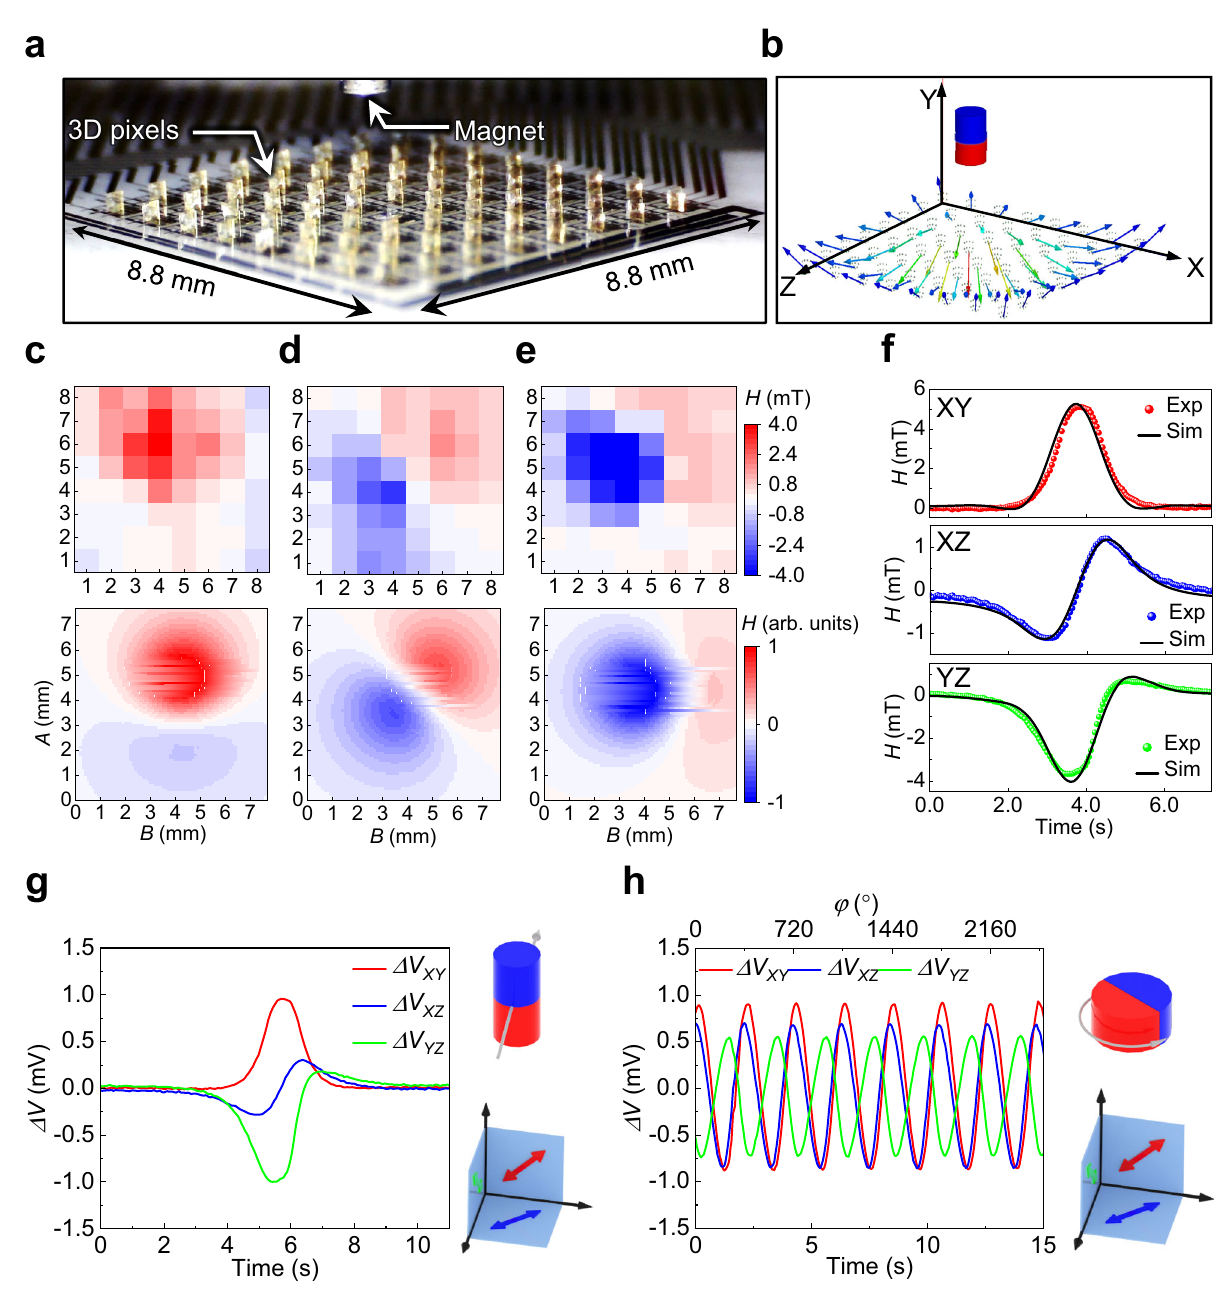
Fig. 3 Static mapping and dynamic tracking of magnetic objects. a Image of an IMOS device together with a small NdFeB permanent magnet. b Simulation result of the magnetic vectors at the locations of the 8 × 8 sensor pixels. c – e Static mapping of the strengths of the magnetic stray fi eld by S XY , S XZ and S YZ sensor arrays on the XY, XZ and YZ planes, respectively. The top panel is from the experimental results and the bottom panel is from simulation. The magnet and its relative position to the sensor array is shown in a . f Simulation result of the dynamic responses of S XY , S XZ and S YZ in a single pixel to the linear motion of a magnet. The dotted lines are measured results and the continuous lines are from simulation. g Dynamic voltage response to a linear motion of the NdFeB permanent magnet monitored by a single pixel. h Dynamic tracking of the rotation of a NdFeB permanent magnet by a single pixel. The output voltages for S XY , S XZ and S YZ change periodically with constant magnitudes emphasizing the stability of the sensors. The 90° phase shift between the signals from S XY and S YZ indicates the orthogonal folding of these two sensing planes. The relative positions of the magnets to the sensor pixels as well as the magnetization directions of the magnets are schematically illustrated on the right of the response curves. Source data are provided as a Source Data fi fi eld of a small NdFeB permanent magnet is performed by placing Static mapping and dynamic tracking of magnetic objects . Static mapping and dynamic tracking of magnetic objects in 3D the magnet over the IMOS device and recording the output space is of signi fi cance for various applications such as the voltages of the 3D sensor arrays (Fig. 3a). Mapping of the mag- localization and navigation of microrobots 53 as well as the feed- netic stray fi eld strengths by the S XY , S XZ and S YZ sensor arrays back control for soft robotics 54 . The static mapping of the stray can be done after calibration of the IMOS device (Top panel in